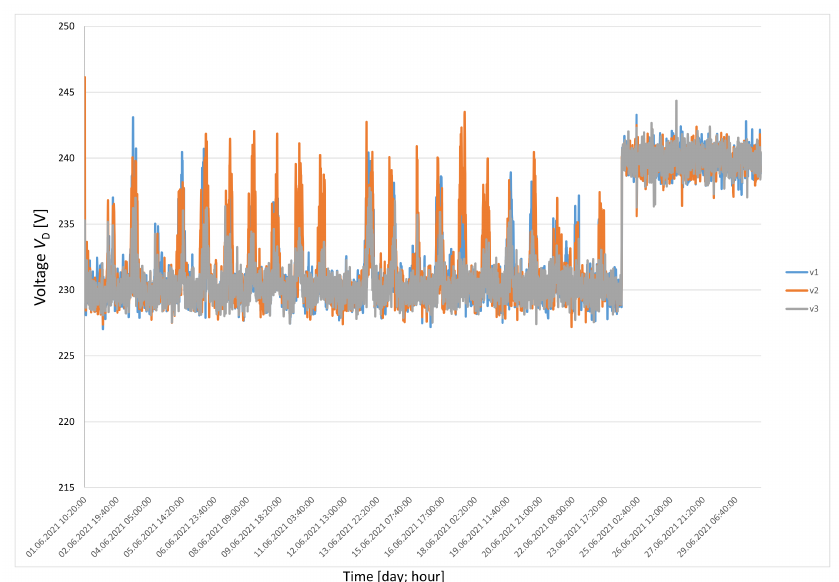
Figure 9. Voltage variations V D for three phases ( v 1 , v 2 , v 3 ); period: 1 June 2021, hour 10:20 a.m. − 29 June 2021, hour 6:40 a.m.